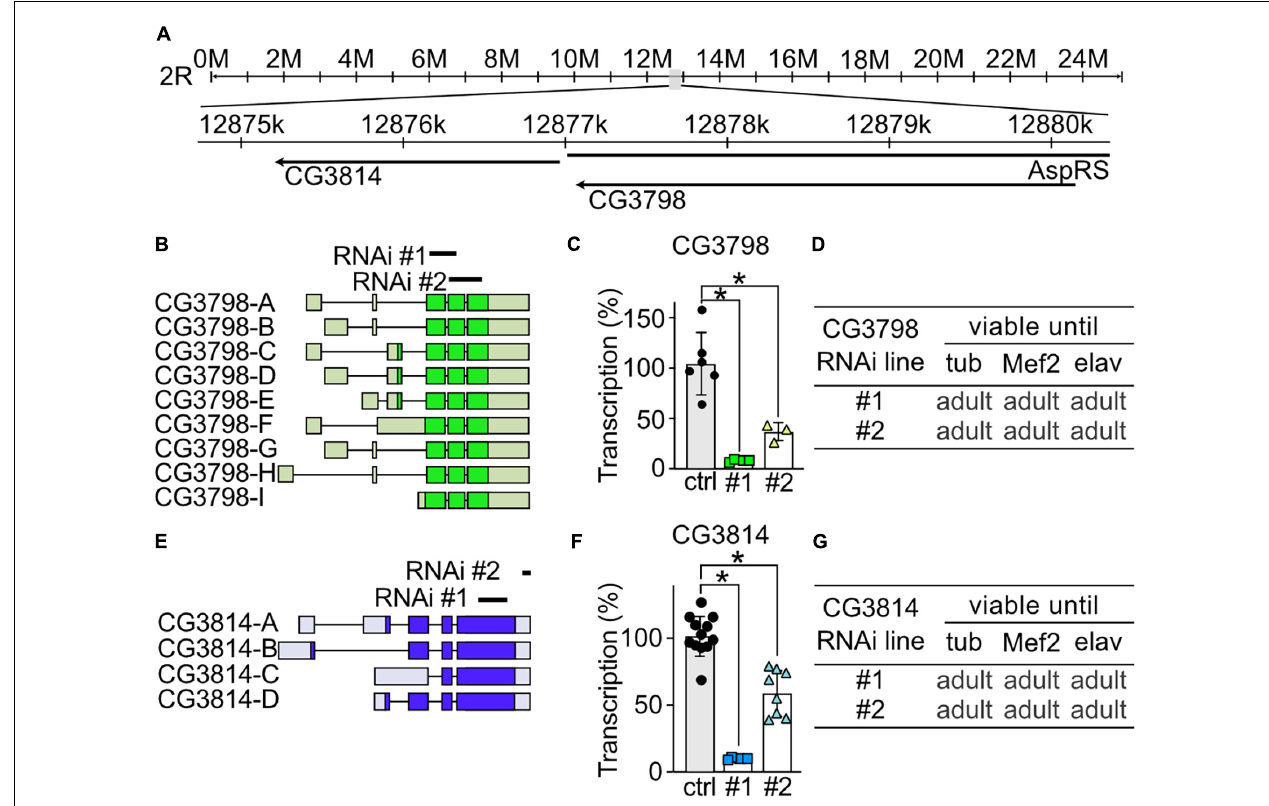
FIGURE 3 | CG3798/Nmda1 and CG3814/Lfg are not essential for the development of Drosophila melanogaster . (A) Genomic location of CG3798/Nmda1 and CG3814/Lfg. M, million base pairs (bp); k, thousand bp; AspRS, Aspartyl-tRNA synthetase. (B,E) Splice isoforms of CG3798/Nmda1 and CG3814/Lfg, respectively. Dark color indicates the open reading frame. The targeting position of the two RNAi lines used in this study are marked as black lines. (C,F) Transcriptional levels of CG3798/Nmda1 and CG3814/Lfg in tubP > > CG3798/Nmda1-RNAi and tubP > > CG3814/Lfg-RNAi whole 2-day-old adult flies determined by qPCR. Each bar represents the mean ± SD and each dot a group of 10 flies. Statistical significance was calculated using one-way ANOVA followed by the Dunnett’s test. ns, not significant. * p < 0.05. (D,G) Viability of CG3798/Nmda1 or CG3814/Lfg KD flies by two RNAi lines driven by the indicated Gal4